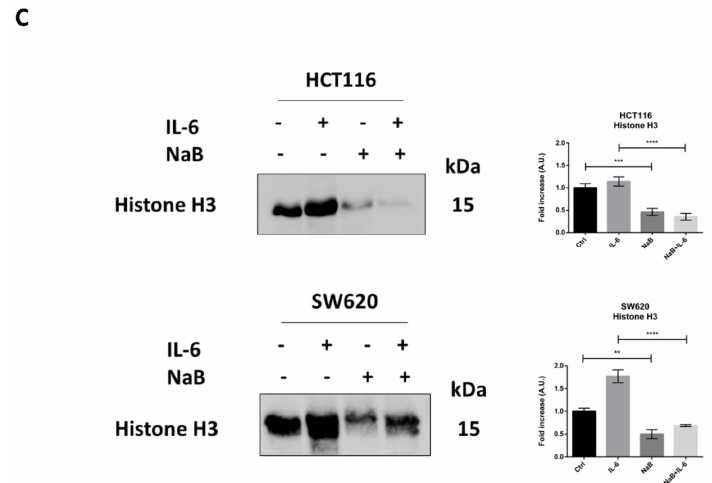
Figure 3. Sodium butyrate opposes IL-6-induced CRC cell proliferation. ( A ) CRC cells growing in polyhema-coated petri dishes were stained with 1 μM DiD and treated with 1 mM NaB in the presence or not of 50 ng/mL IL-6. The intensity of Did retention in spheroids was acquired with a fluorescence microscope (scale bar = 8.5 μ m, magnification = 63×) at days 0 and 5 and quantified with the software ImageJ. A representative microscopic field for each condition is shown. The graph represents the average fluorescence ± SD (significance was considered as follow: **** p < 0.0001). ( B ) Cell lines were cultured and treated as above. After 5 day-treatment, spheroids were stained for the proliferation marker p21 (red) and acquired at the fluorescence microscope (scale bar = 8.5 μ m , magnification = 63×). Representative images for each condition are shown. ( C ) Spheroid homogenates were processed using Western blotting. An equal volume of homogenate (35 μL) was loaded to evaluate the expression of the nuclear marker histone H3 after 5 days of incubation with NaB and/or IL-6. A representative Western blotting out of three, with reproducible data, is shown and densitometric data are shown in the panel. The graphs represent the average ± SD (significance was considered as follow: ** p < 0.01, *** p < 0.001, **** p < 0.0001).